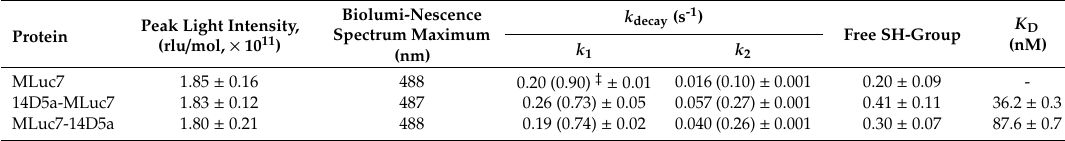
Figure 1. ( a ) Schematic representation of genetic constructs of hybrid proteins based on MLuc7 and 14D5a single-chain antibody for production in baculovirus expression system. S, MLuc7 secretion peptide; ML7, MLuc7 luciferase sequence without secretion peptide; 14D5a, 14D5a single-chain antibody; H7, His7-tag. ( b,c,d ) Properties of 14D5a-MLuc7 (grey lines and circles) and MLuc7-14D5a (dashed lines and open circles) hybrid proteins vs those of wild type MLuc7 (black lines or circles). ( b ) Bioluminescence spectra recorded at 23 °C. ( c ) Effect of temperature on bioluminescence activity (data represent average of 3 independent experiments for each protein). ( d ) Kinetics of bioluminescent reaction recorded at 23 °C. The measurements were performed in ML-buffer with 1:10,000 protein/substrate molar ratio. Light intensity is expressed as relative to peak values (rlu, relative light units). Table 1. Properties of hybrid proteins.